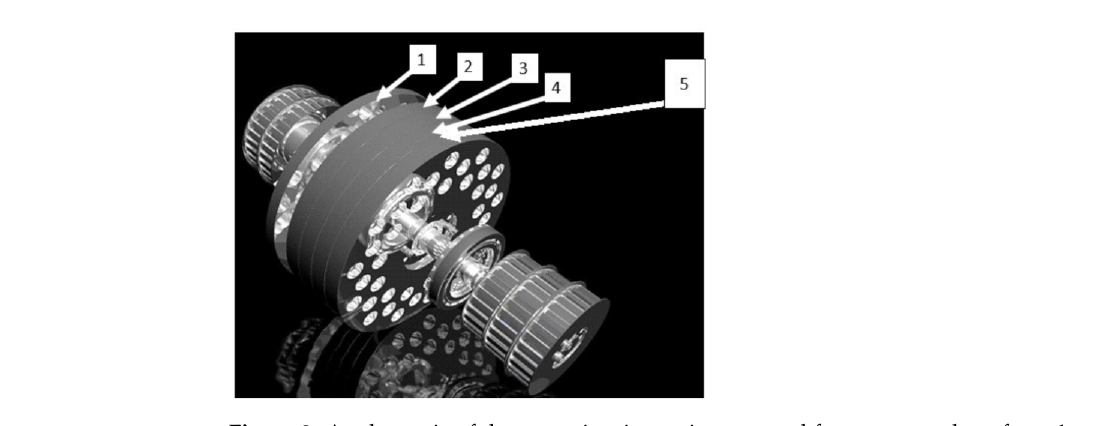
Figure 2. A schematic of the comminution unit structural features; numbers from 1 to 5 represent successive discs [43]. Table 1. Design details of comminution